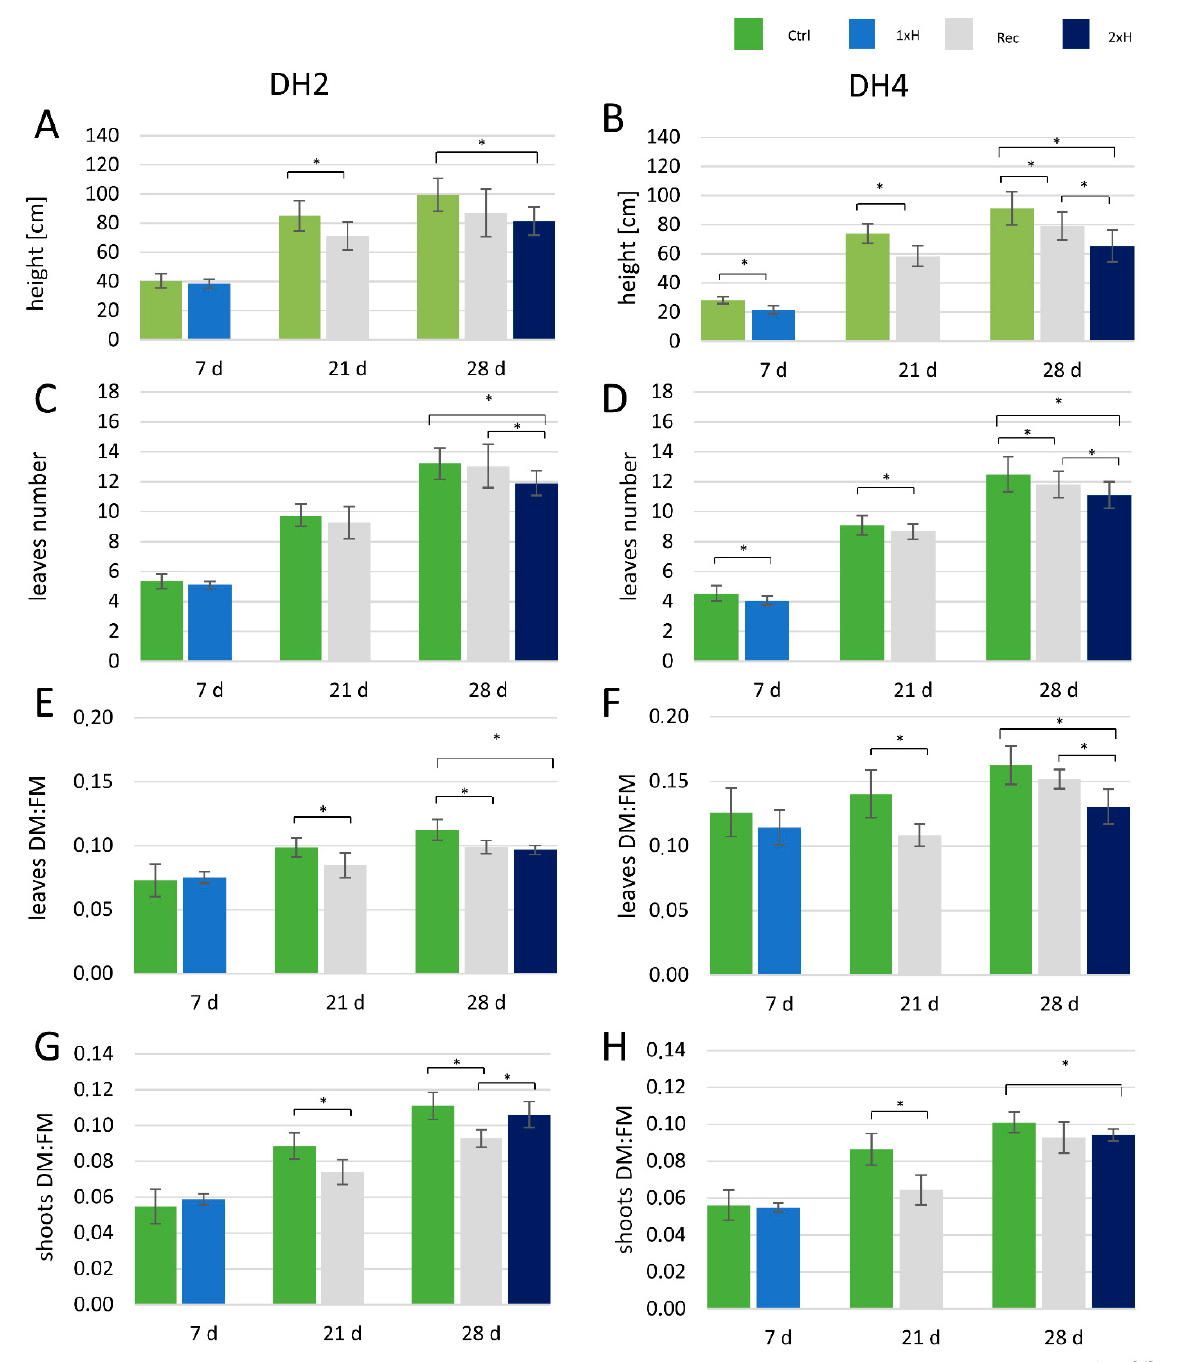
Figure 3. Effect of waterlogging on the plant height ( A , B ), leaves number ( C , D ), DM:FM ratio in leaves ( E , F ) and shoots (without leaves) ( G , H ) in DH2 and DH4 cucumber accessions, respectively. DM—dry mass, FM—fresh mass. Values are mean ± standard deviation ( n = 10 for plant height and leaf number, n = 6 for FM and DM). * Indicates a significant difference between the indicated treatments at p ≤ 0.05 according to Student’s t